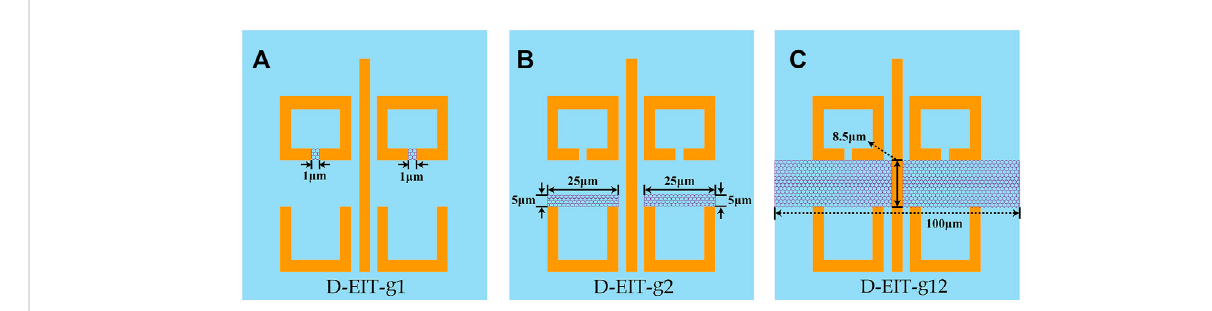
FIGURE 5 Schematics of the unit cells of (A) D-EIT-g1, (B) D-EIT-g2, (C) D-EIT-g12.